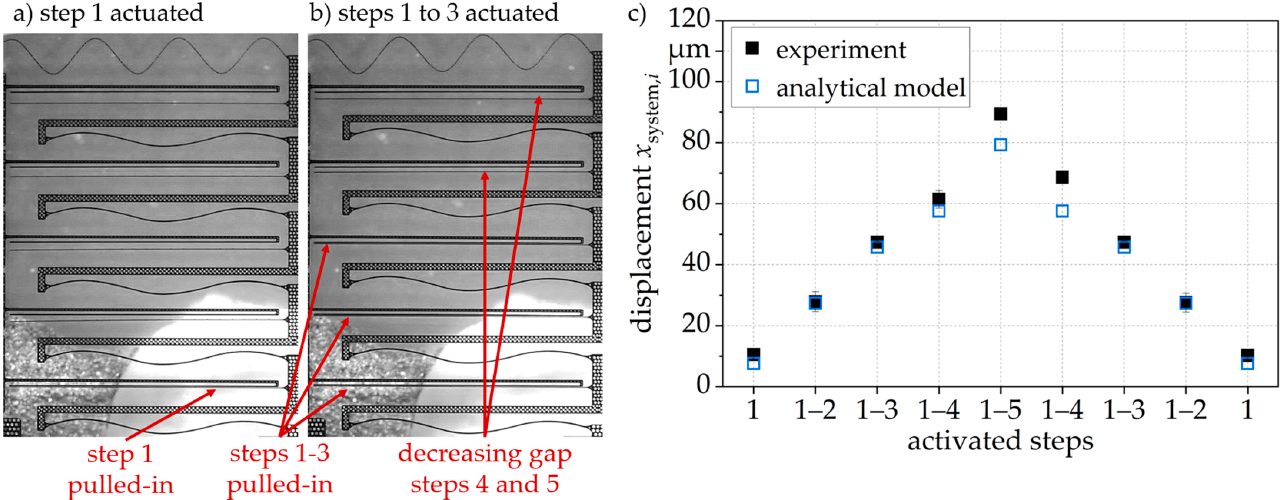
Figure 11. Step-by-step actuation of system 2 (left hand side) at 97 V, relays closed at ( a ) step 1, ( b ) steps 1 to 3, ( c ) experi- mental and analytical displacement of system 2 at 97 V control voltage, Table 2 presents the exact measured results.